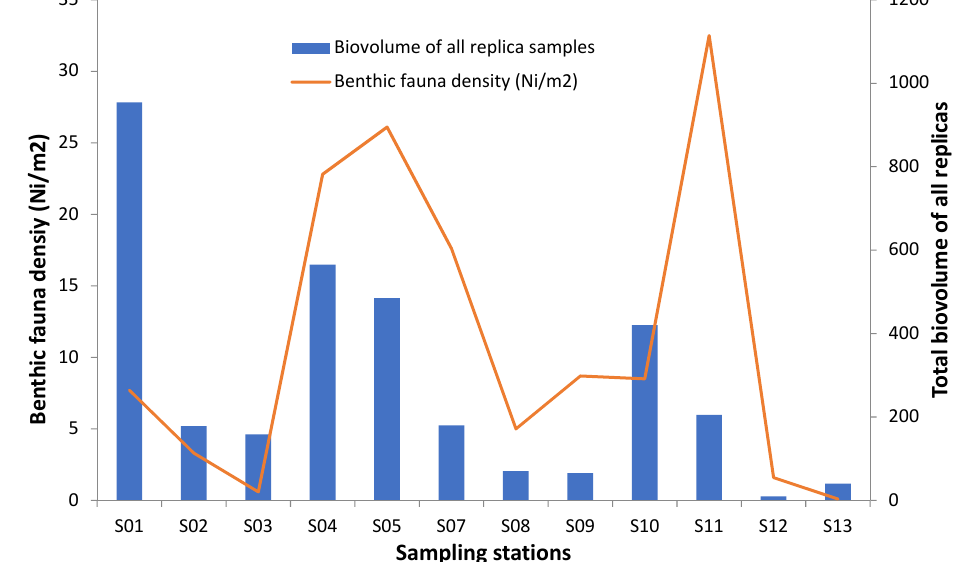
Figure 2. Biovolume of all replicates and benthic fauna diversity for the different sampling stations.